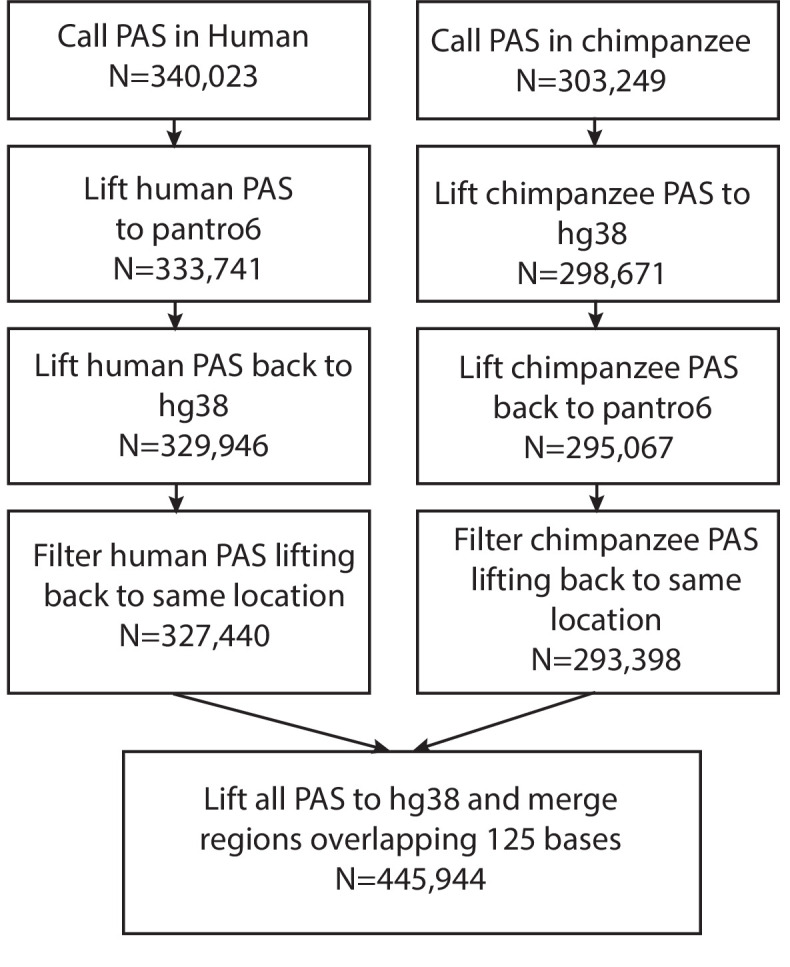
Reciprocal liftover pipeline.Reciprocal liftover pipeline for unfiltered polyadenylation sites (PAS) including the number of sites remaining at each step. Liftover using UCSC liftover tool and chain files downloaded from UCSC Genome Browser.